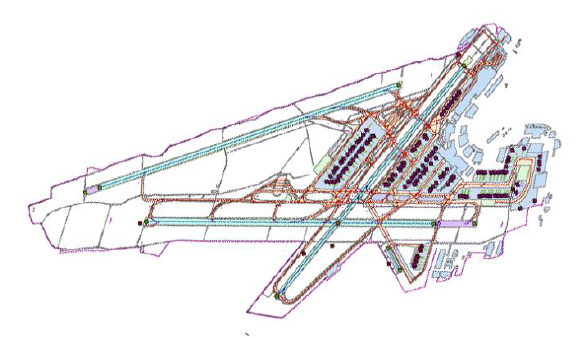
Figure 6: GIS layers of an airport